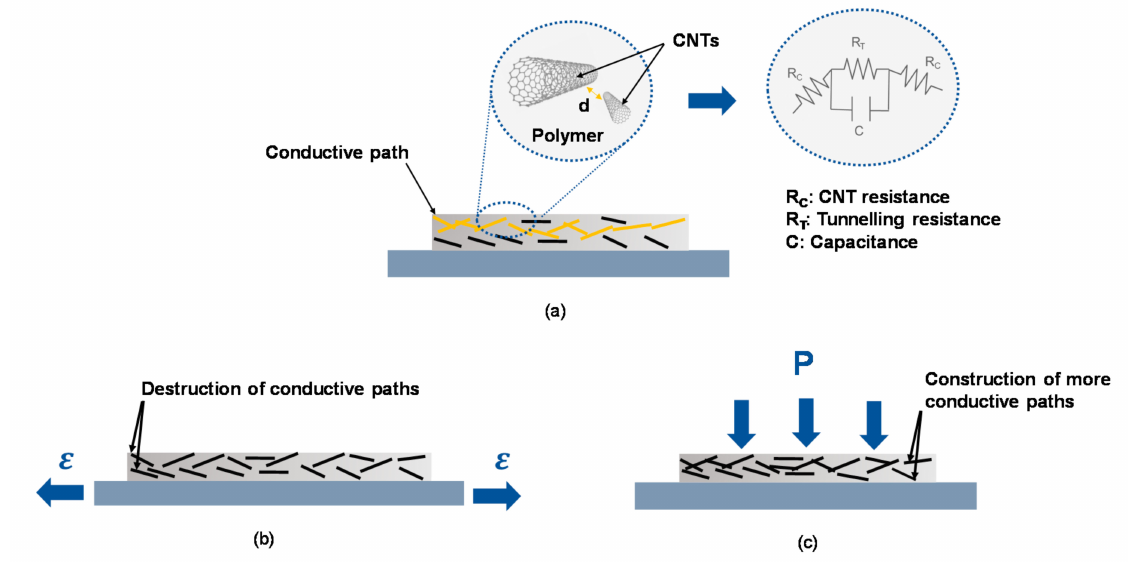
Figure 3. Conduction mechanisms of polymer/carbon nanotube (CNT) sensor: ( a ) without load, ( b ) under strain and ( c ) under